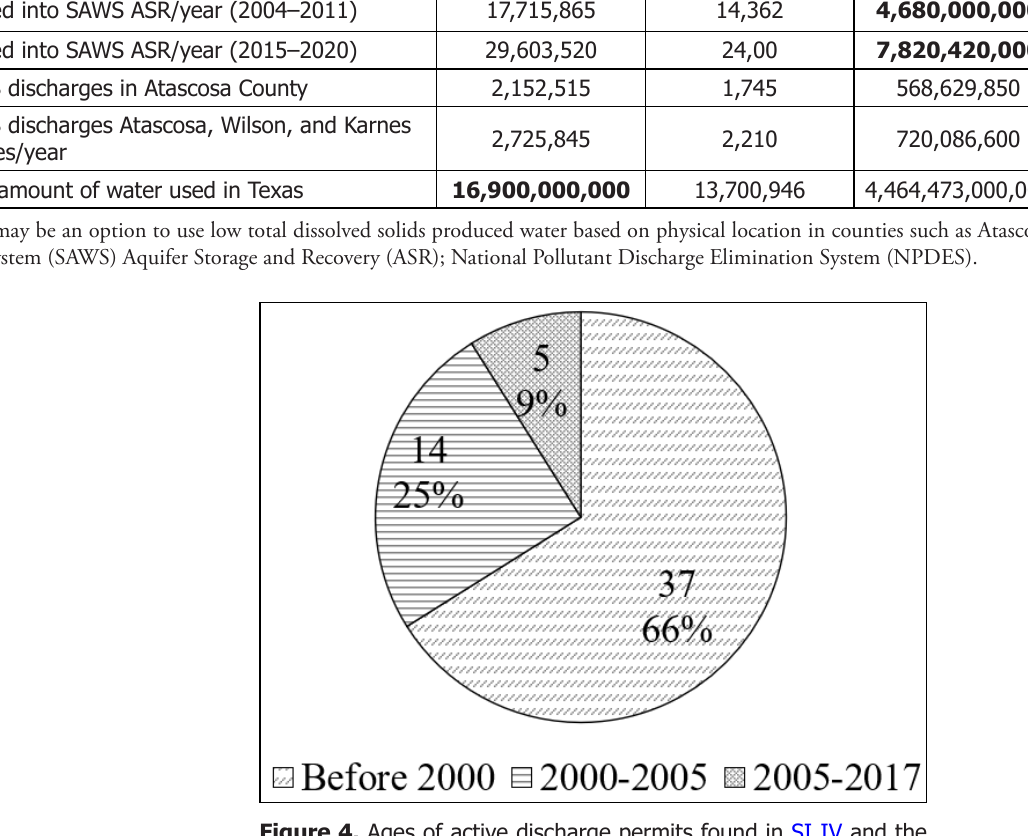
Figure 4. Ages of active discharge permits found in SI IV and the number of active discharge points that have been running since the dates provided by the Railroad Commission of Texas.